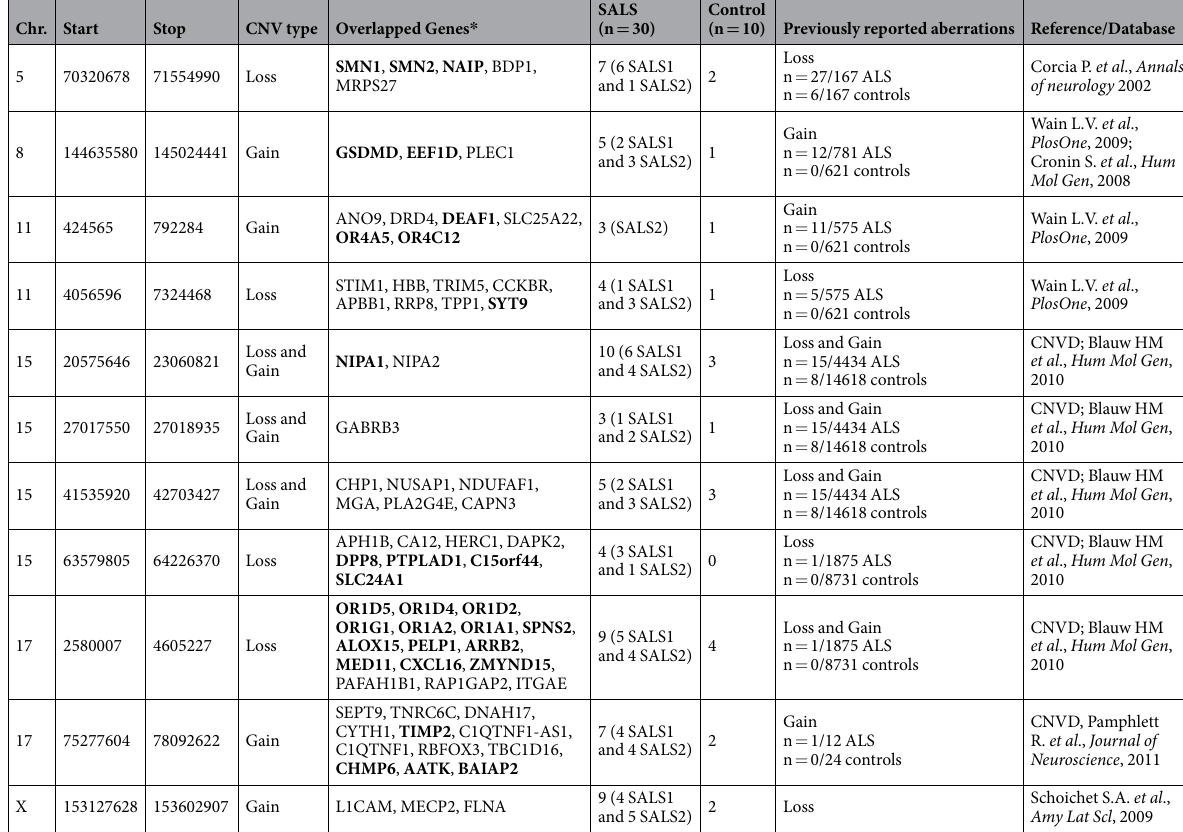
Table 3. Characteristics of the most frequent CNV regions detected in SALS patients and previously associated to ALS from different database and/or published literature. The table shows the most frequent CNV loci and relative NeuroArray genes that partially or completely overlap with genomic aberrations previously associated to ALS cases and reported in publicly available databases (i.e., CNVD) and/or published PubMed literature. The chromosomal regions, including the start and end positions, aberration type and CNV embedded NeuroArray genes are listed. In addition, the number of controls and ALS cases from both our experiment and previous scientific reports of these CNV loci was also shown. Chromosomal positions are referred to the human reference sequence hg19 assembly. Genes that may be reasonable ALS candidates are in bold. Chr: